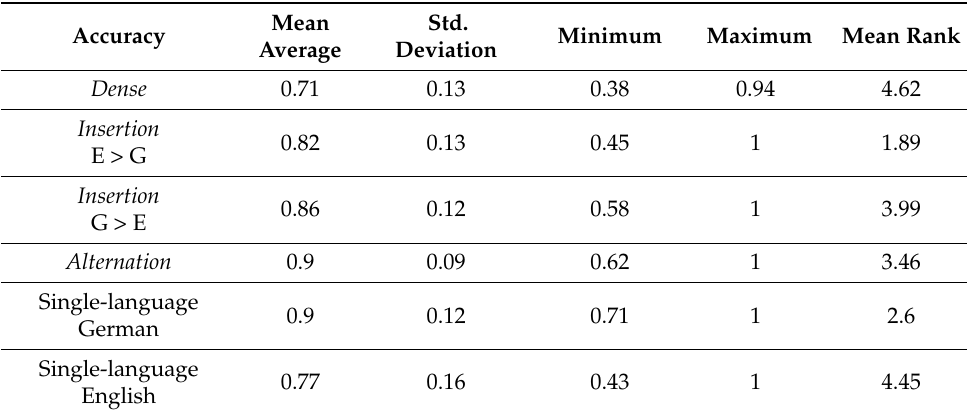
Table 1. Accuracy in the sentence repetition